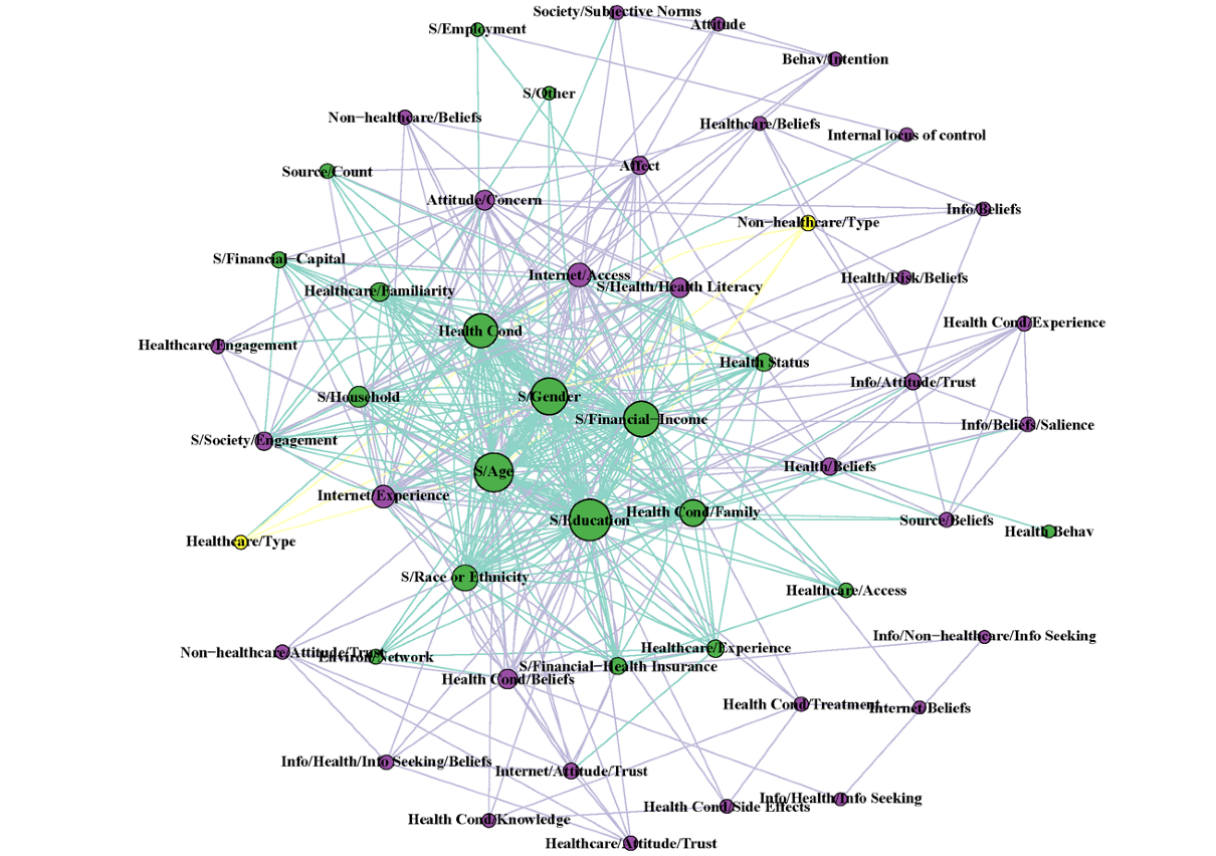
Figure 3. Fruchterman-Reingold layout algorithm of the network analysis comparing the pre- and including 2008 network models with color coding according to the modularity group membership of the complete model. The repository is available on GitHub